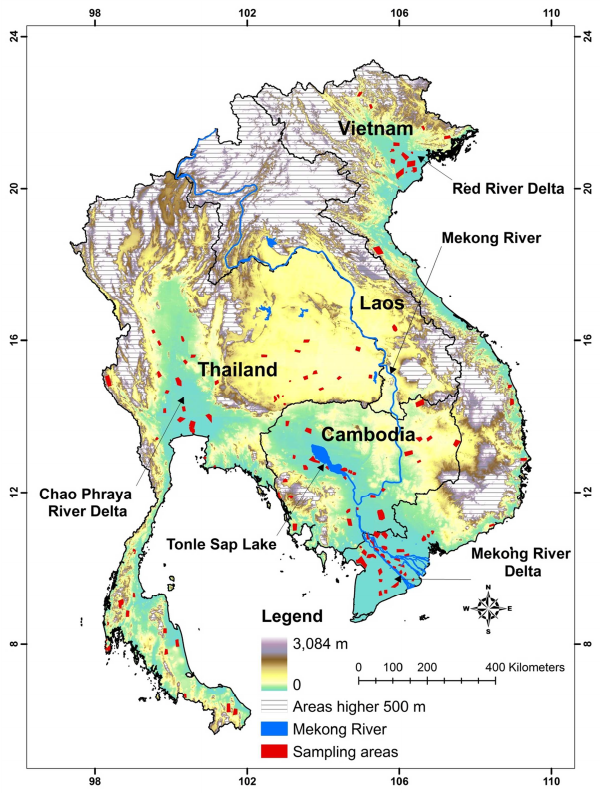
Figure 1. Map of the study area showing the sampling areas (ground reference data) used for extracting training data used in ANNs and evaluating accuracy classification